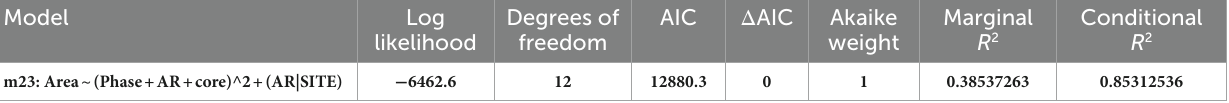
TABLE 4 Log likelihood, AIC and Akaike weights of the only model with non-zero AIC weight containing the explanatory variable (aspect ratio), climate phase and core/edge site as random effects and site as fixed effect performed on the data of Truncorotalia crassaformis . Model